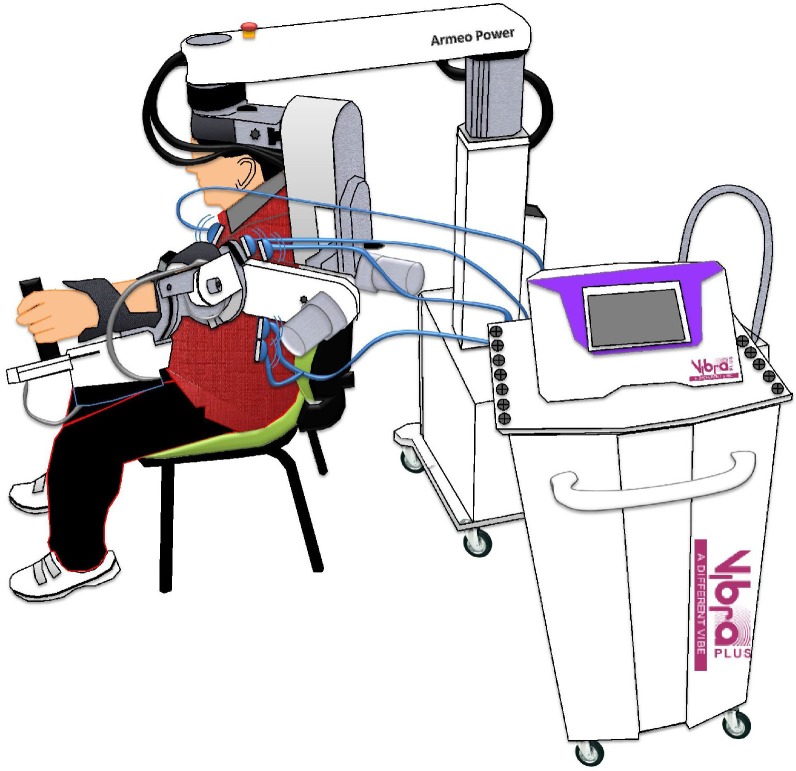
Combined rehabilitative approach.